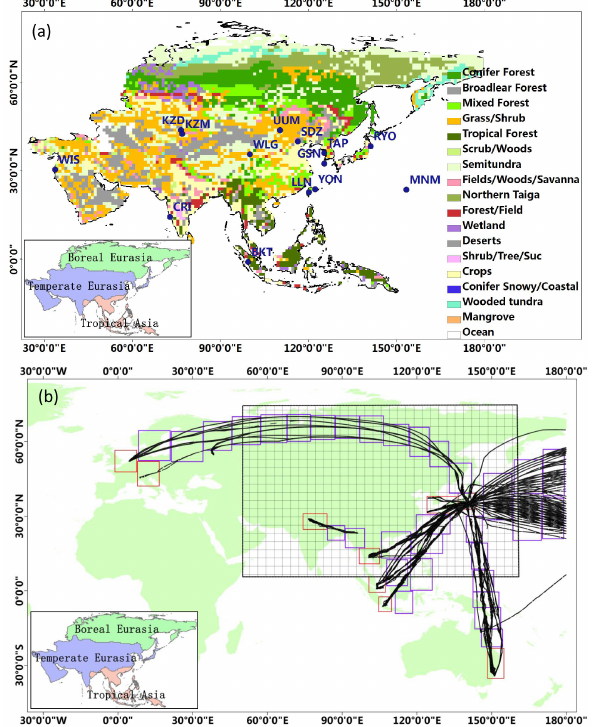
Figure 1. (a) Map of the Asian surface observation sites, along with the map of the ecoregion types from Olson et al. (1985) with 19 land cover classes as used in this study. These Asian surface obser- vation data download from the NOAA-ESRL (e.g., Mt. Waliguan, China (WLG), Bukit Kototabang, Indonesia (BKT), Sede Boker, Is- rael (WIS), Sary Taukum, Kazakhstan (KZD), Plateau Assy, Kaza- khstan (KZM), Tae-ahn Peninsula,South Korea (TAP), Ulaan Uul, Mongolia (UUM), Cape Rama, India (CRI)) and WDCGG network (e.g., Lulin, Taiwan (LLN), Shangdianzi, China (SDZ), Minamitor- ishima, Japan (MNM), Ryori, Japan (RYO), Yonagunijima, Japan (YON), Gosan, South Korea (GSN)); (b) CONTRAIL CO 2 obser- vations map, along with 42 horizontal regions. The red rectangles represent the nine regions covering the ascending and descending data (included four vertical bins at 575–625, 475–525, 375–425, 225–275hPa) over airports, and the blue rectangles indicate the other 33 regions covering the cruise data (included one bin at 225– 275hPa). The big black rectangle indicates a zoom region over Asia (1 ◦ × 1 ◦ ) based on global grid (3 ◦ × 2 ◦ ). Note that “Asia” refers to lands as far west as the Urals in this study and it is further divided into boreal Eurasia, temperate Eurasia and tropical Asia based on TransCom regions (Gurney et al., 2002; Gurney et al., 2003). These divided regions are presented in the small inset in the bottom left corner (same as